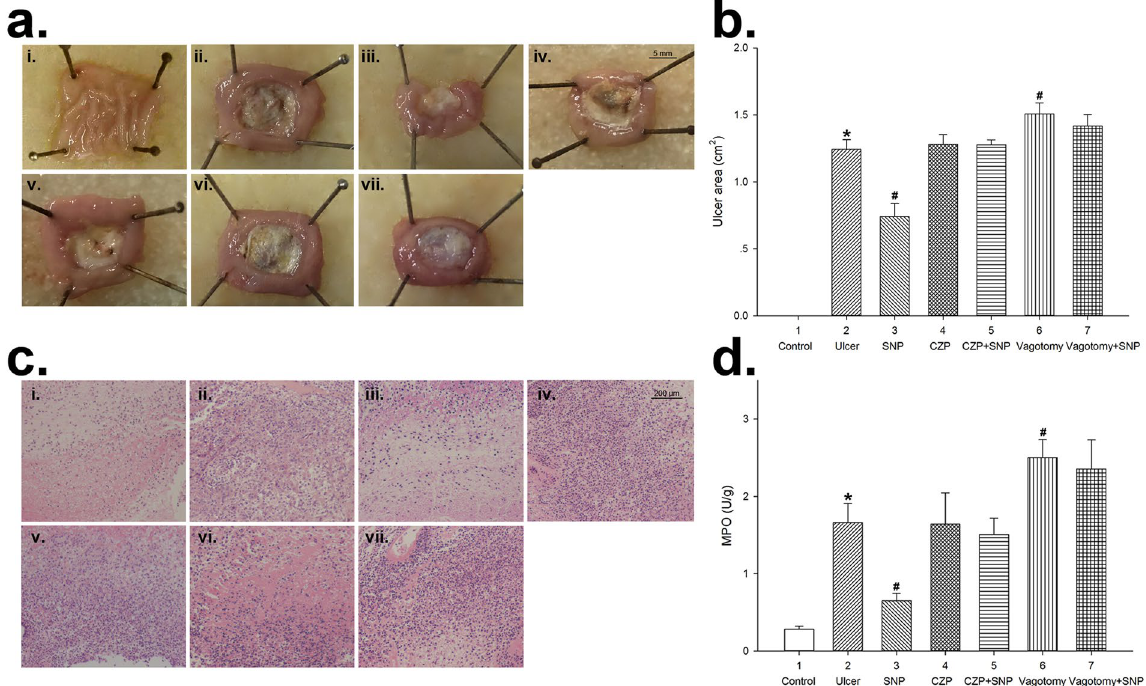
Figure 1. Sodium nitroprusside (SNP) alleviated acetic acid-induced gastric ulcer in rats, which was mediated by TRPV1 and vagus nerve. ( a ) Photographs showing the gross appearance of the gastric mucosa in rats treated with acetic acid in the wall of stomach compared with normal tissue of NS control group. Different sizes of ulcer are seen in the six acid-treated groups except the NS control. (i) NS control group; (ii) ulcer control group; (iii) SNP (3 mg/kg, i.p., bid) group; (iv) CZP (1.2 mg/kg, i.p., bid) group; (v) CZP + SNP group; (vi) vagotomy group; (vii) vagotomy + SNP group. ( b ) Summary values showing the gastric ulcer area (UA) in the seven groups. SNP treatment decreased UA. TRPV1 antagonist didn’t produce higher UA, but reduced the effect of SNP. Prior subdiaphragmatic vagotomy increased UA, and abolished the protective effective of SNP. n = 10 in vagotomy group, n = 6 in the other six groups, * P < 0.05 vs NS control group, # P < 0.05 vs ulcer control group, Dunn’s post